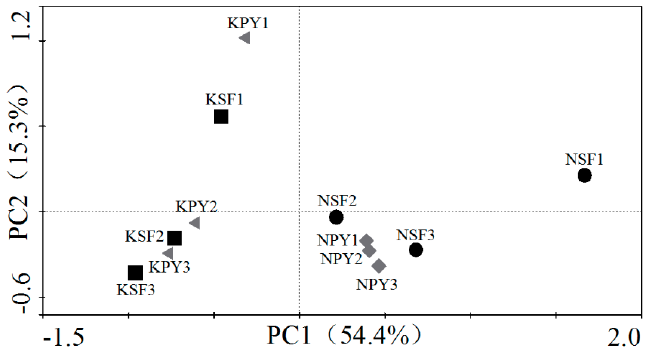
Table 4. Eigenvalues and cumulative variances of the redundancy analysis ordination of the soil microbial community.